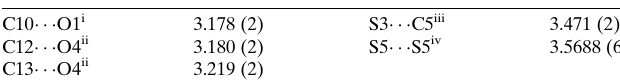
Table 1 C (cid:4)(cid:4)(cid:4) O, S (cid:4)(cid:4)(cid:4) C and S (cid:4)(cid:4)(cid:4) S short contacts (A˚ ). C10 (cid:4)(cid:4)(cid:4) O1 i 3.178 (2)